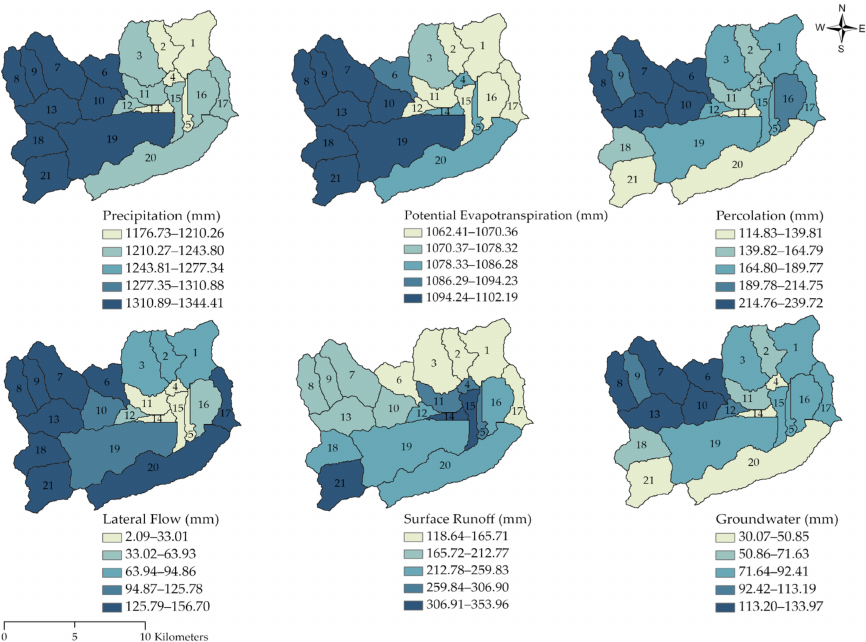
Figure 7. Spatial distribution of water balance components at sub-basin level in